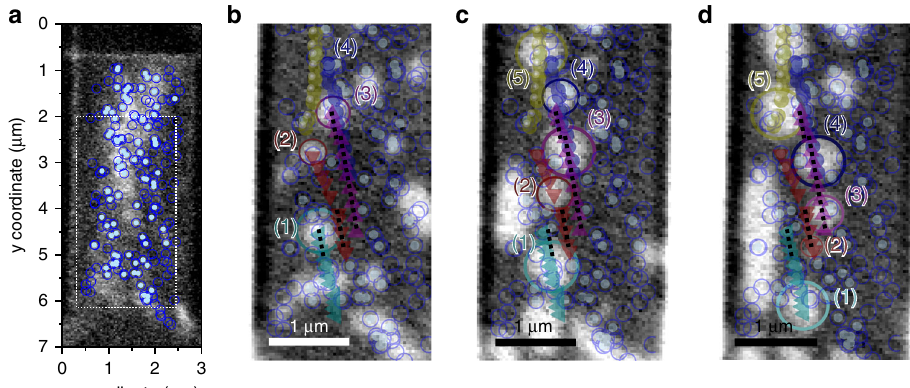
Fig. 7 Energy landscape dominated motion. a Skyrmion nucleation sites superimposed on the map shown in b (open blue circles) versus nucleation site of moving skyrmion (full light blue circles). b – d Zoom in of the area surrounded by the white dotted square in a . The centre positions of selected skyrmions imaged at − 1 mT are superimposed as solid, spheres, triangles and hexagons, respectively. Changes to the centre trajectory as the skyrmions travel through the wire are apparent. Trajectory changes were observed to occur due to pinning sites (1), (3) and (4) and skyrmion – skyrmion (5) or skyrmion- magnetic domain de fl ection (2). When local effects do not dominate, the skyrmions follow a trajectory around 10° (dotted black line) which is consistent with the angles predicted by the Thiele equation for skyrmions with a diameter larger than 250